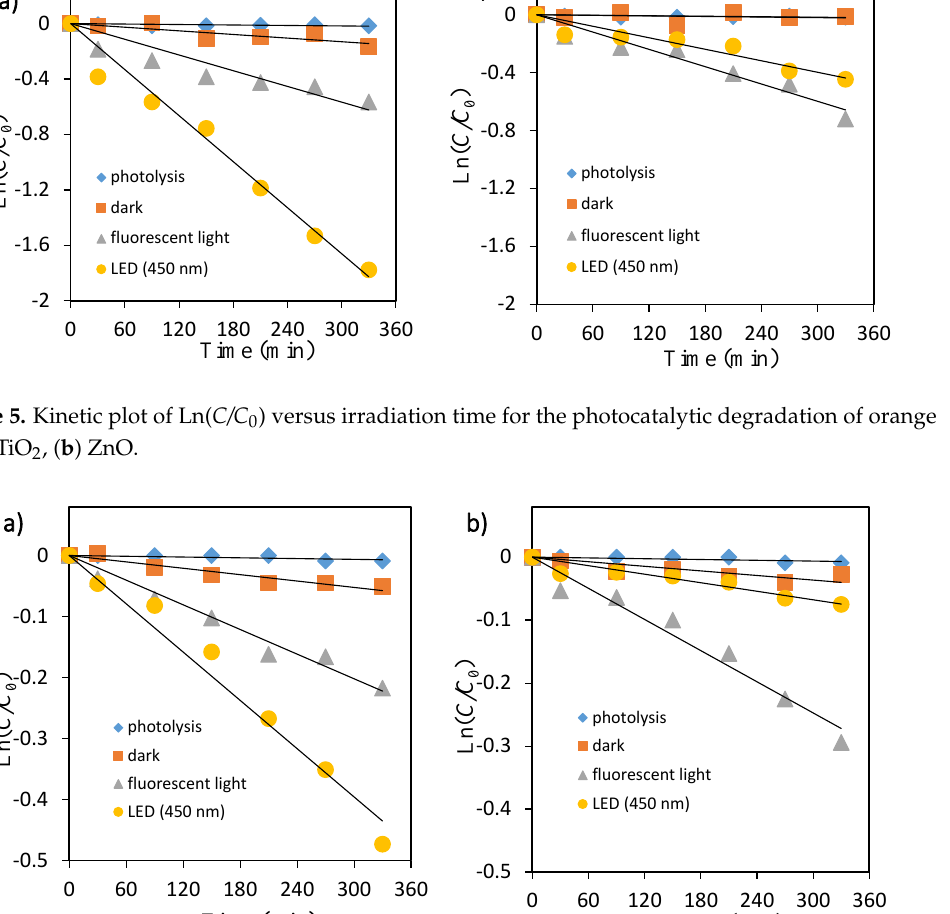
Table 2. Rate constants, R 2 , and half-life values of OII and MO dyes using TiO 2 and ZnO.